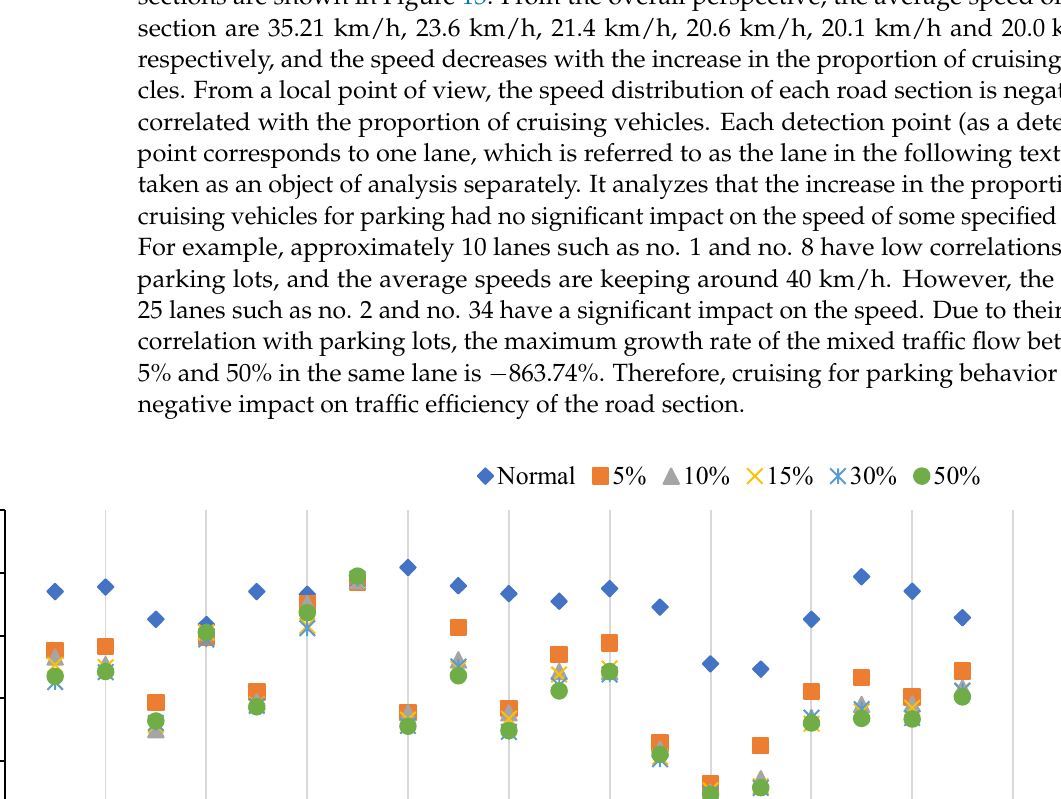
Figure 14. Comparison of average speed at Section 12 and Section 14.